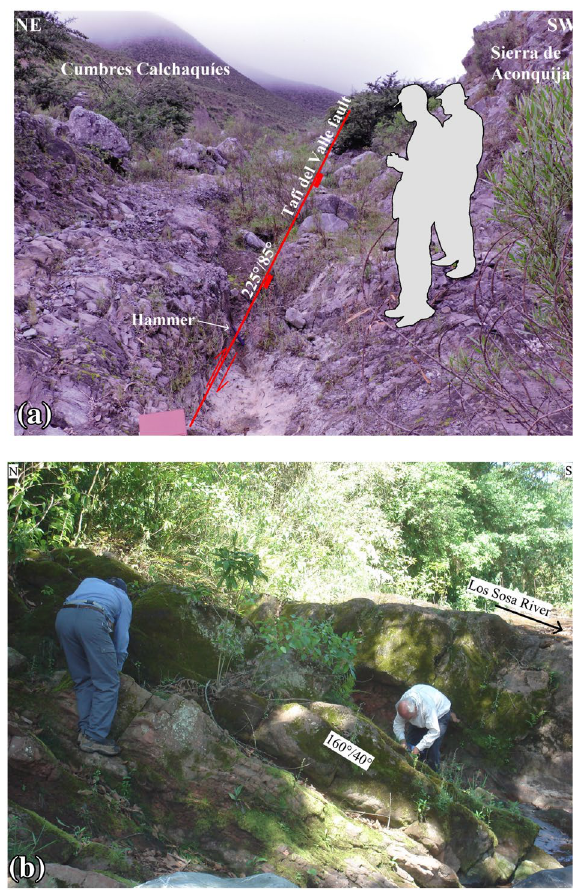
Fig. 3 a View of the Tafí del Valle fault with normal and dextral transcurrent displacement components. The hammer indicates the fault plane, high angle. It marks the limit between the Sierra de Aconquija and the Cumbres Calchaquíes. b Reduced outcrop of sandstones and conglomerate siltstones of the Santa Bárbara Subgroup, Salta Group, on both banks of the Los Sosa River, south‑ ern end of the Chasquivil fault. The sedimentary strata dips to the southeast (160°/40°) tilted by the Chasquivil fault. The location of the photo can be seen in Fig.